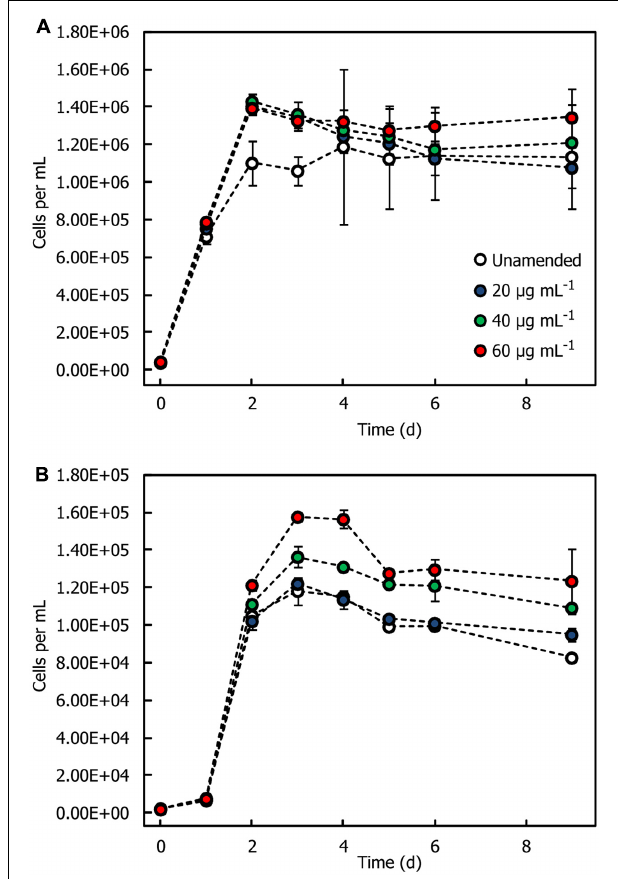
FIGURE 4 | Growth response of bacterial isolates in seawater amended with HMWDOM polysaccharides. (A) Sulfitobacter sp. HI0054. (B) Oleiphilus sp. HI0066. Treatments correspond to cultures grown in unamended seawater that had been enriched in nutrients, vitamins and trace metals, and seawater amended with 20, 40, and 60 µ g mL − 1 of HMWDOM polysaccharides, respectively. The plot indicates the mean cell count of triplicate cultures. Error bars represent one standard deviation.